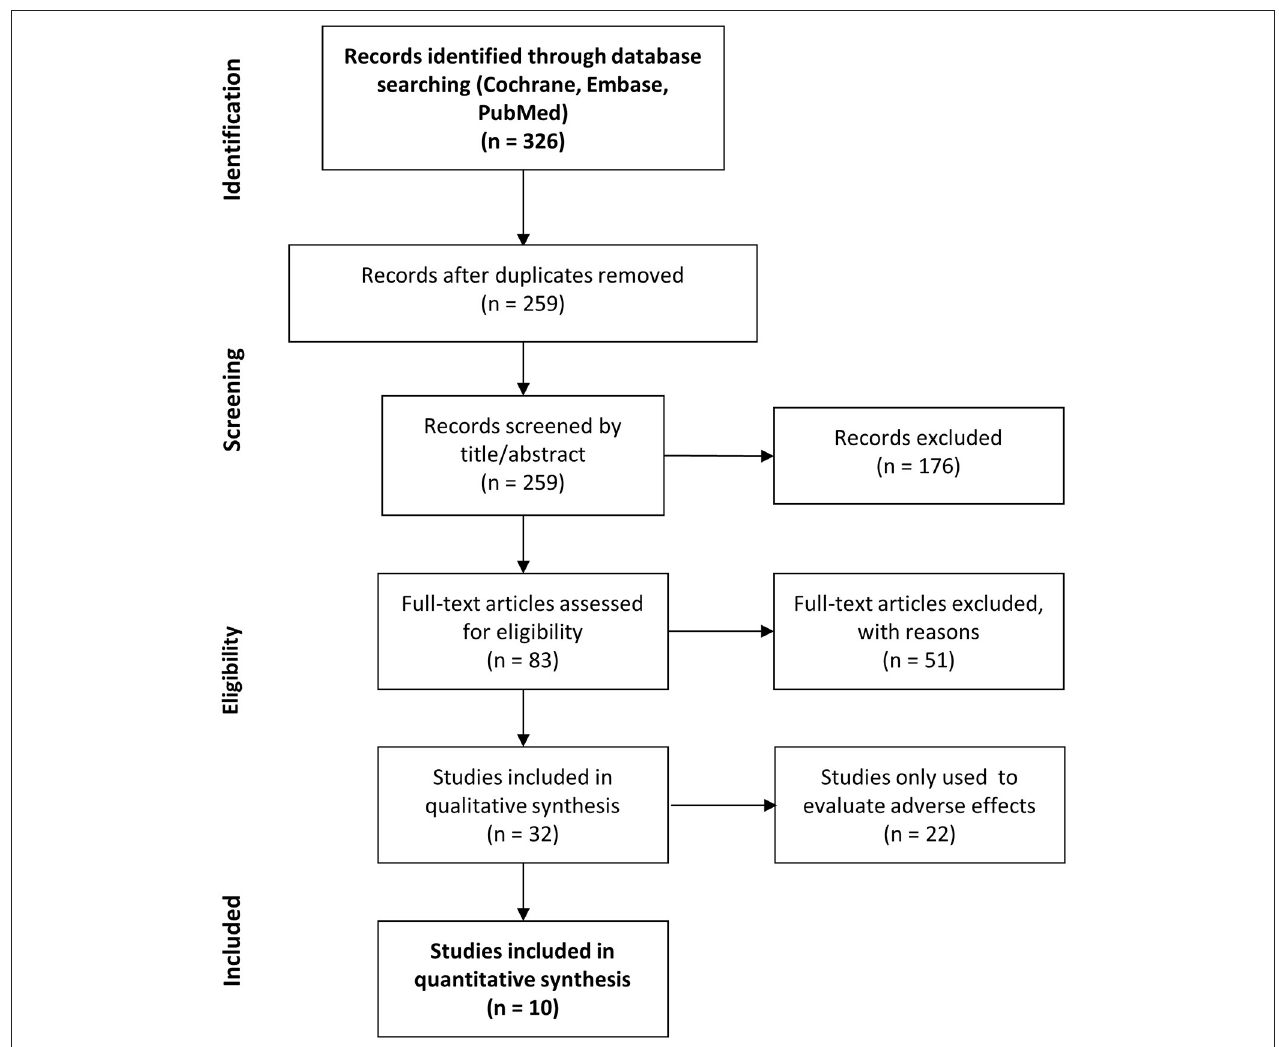
FIGURE 1 | PRISMA flow chart. Summarizing the study selection